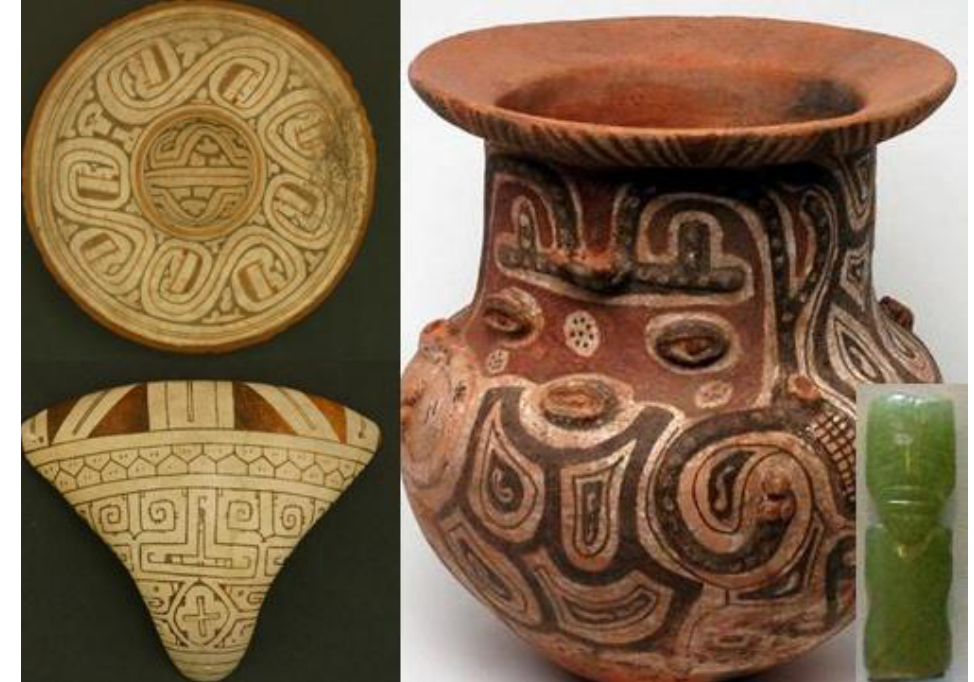
Figure 6. Marajoara phase ceramics and green stone trade item. Plate, tanga, and greenstone from the Banco Santos Colletion, Museu de Arqueologia e Etnologia da Universidade de São Paulo. Photographs by Denise Andrade. Funerary urn from an anonymous collector. Anonymous